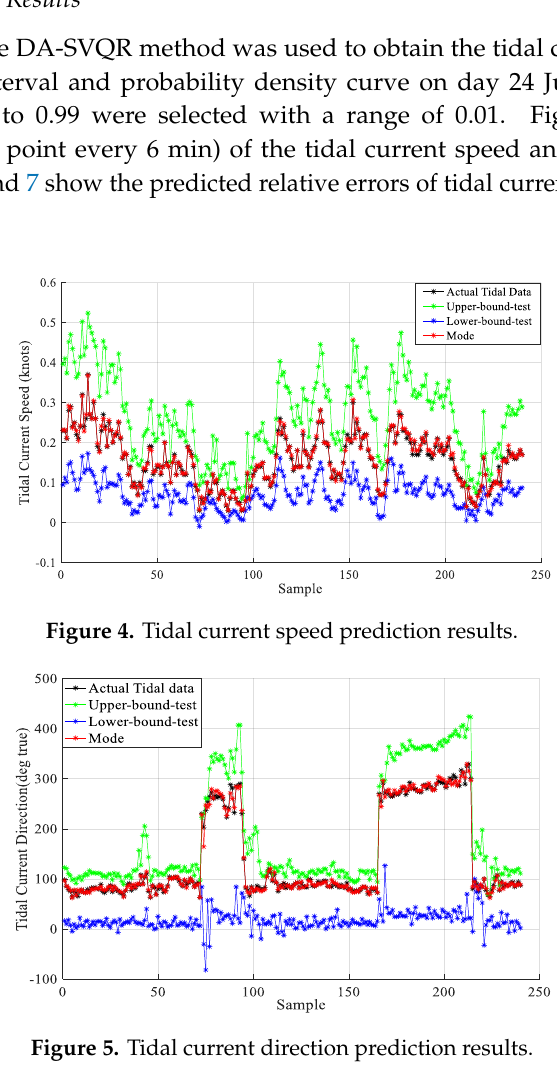
Figure 5. Tidal current direction prediction results.